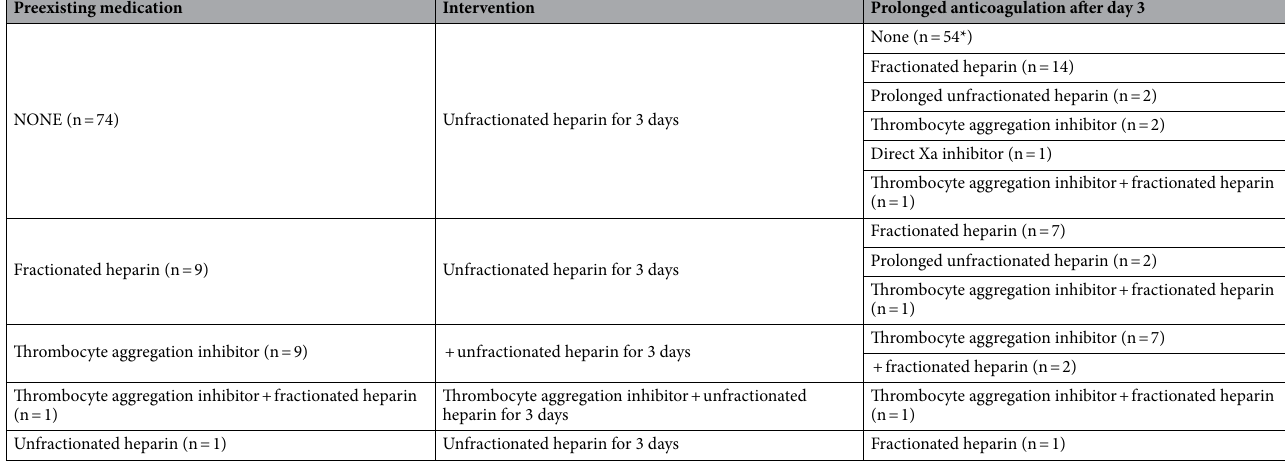
Table 2. Anticoagulation scheme. *Study group.